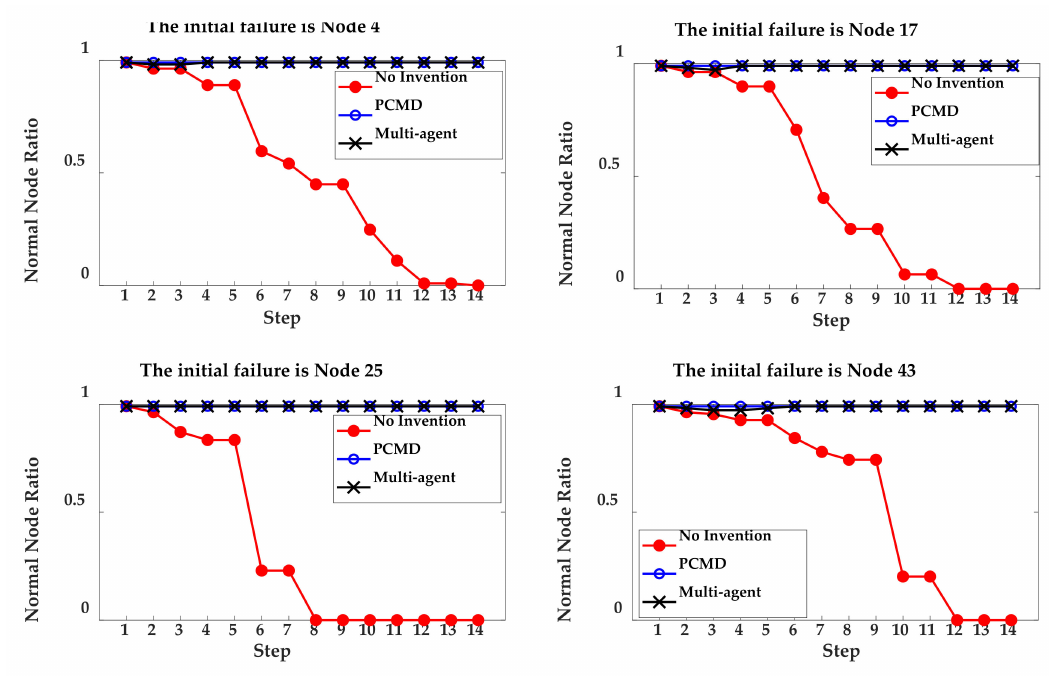
Figure 5. Comparison diagram of CCF initiated from a node failure in the PN.